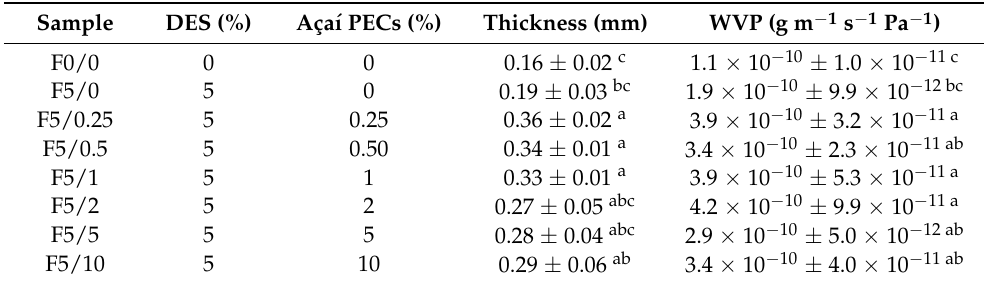
Table 1. Formulation of the CS-DES based films incorporated with aça í PECs and their thickness and water vapor